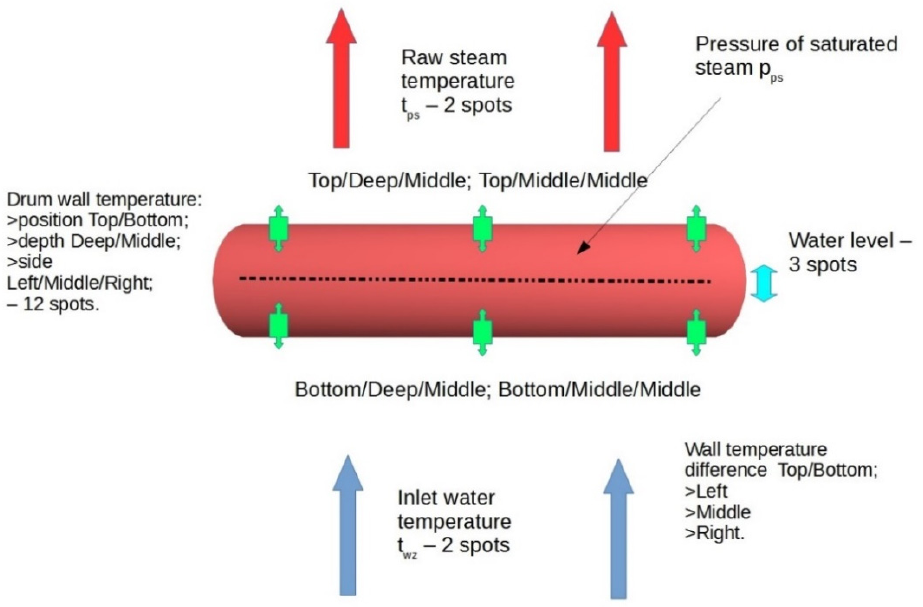
Figure 1. Schematic diagram of the temperature and pressure measuring systems of a boiler drum, with thermocouple locations indicated.